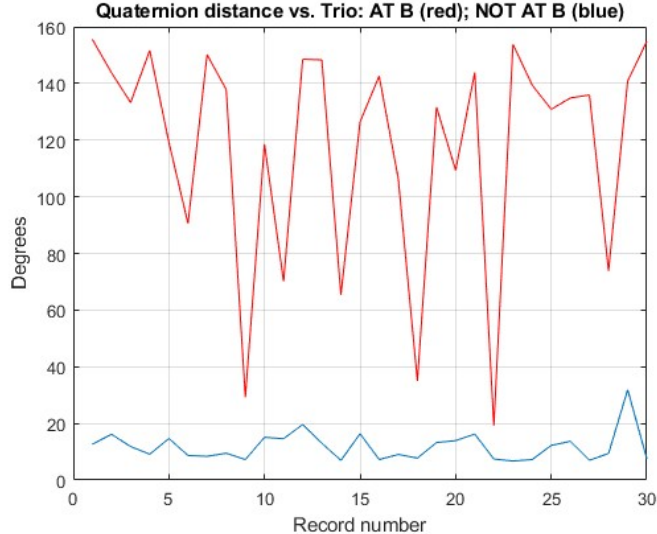
Figure 6. RMS values of quaternion distance (Trio vs. onboard Kalman filter) for the recordings in the FIUMARGDB. The red trace represents the RMS value calculated only in the interval when the MARG was in the neighborhood of Location B (at B). The blue trace represents the RMS value of the remainder of the record (not at B).